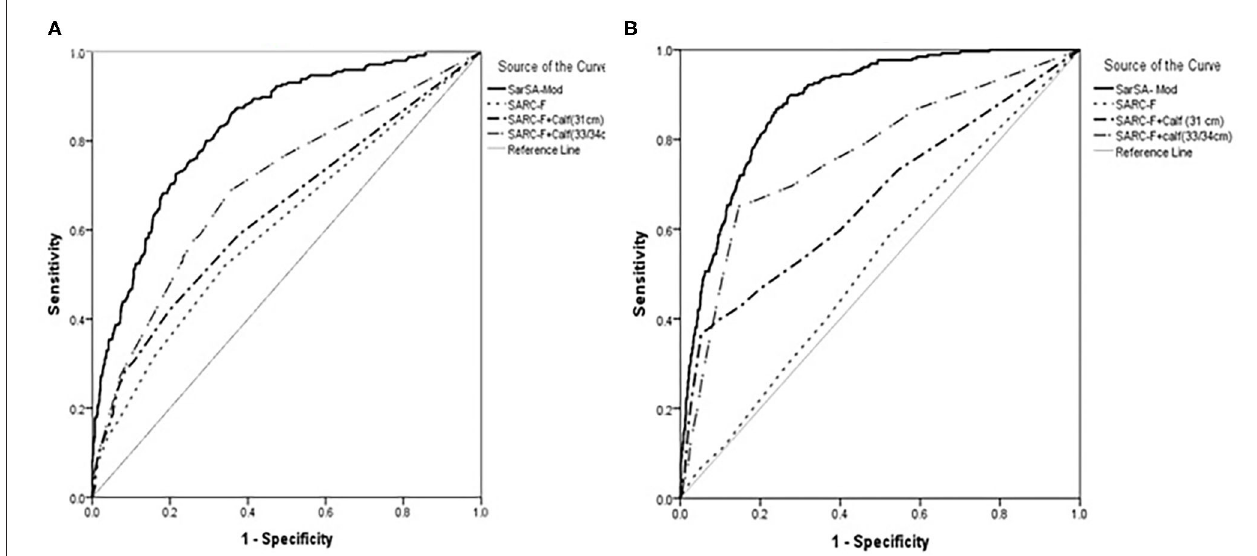
FIGURE 1 | The receiver operating characteristic (ROC) curve for SarSA-Mod (Sarcopenia Scoring Assessment Model), SARC-F, SARCF-Calf (31cm) and SARCF-Calf (33/34cm) in the total population in (A) men and (B) women.